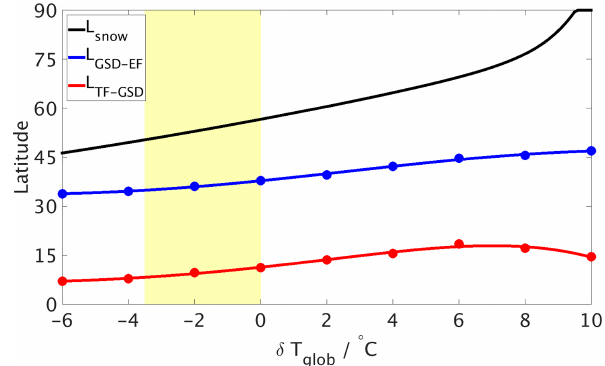
Figure 1. Polynomial functions describing the dynamic latitudes of the borders between the three vegetation zones as function of the global mean atmosphere temperature ( δT glob ) deviation and the latitude of the “snow line“ (black). Red: border between the TF and the GSD zone ( L TF-GSD ). Blue: border between the GSD and the EF zone ( L GSD-EF ). The dots mark the points from the curve fitting as described in the text. The yellow bar marks the region between LGM and PI climate conditions. PI: δT glob , PI = 0 ◦ C, L TF-GSD , PI = 11.28 ◦ , L GSD-EF , PI = 37.77 ◦ , L snow , PI = 55 ◦ ; LGM: δT glob , LGM =− 3.5 ◦ C; L TF-GSD , LGM = 7.17 ◦ ; L GSD-EF , LGM = 33.92 ◦ , L snow , LGM = 51 ◦